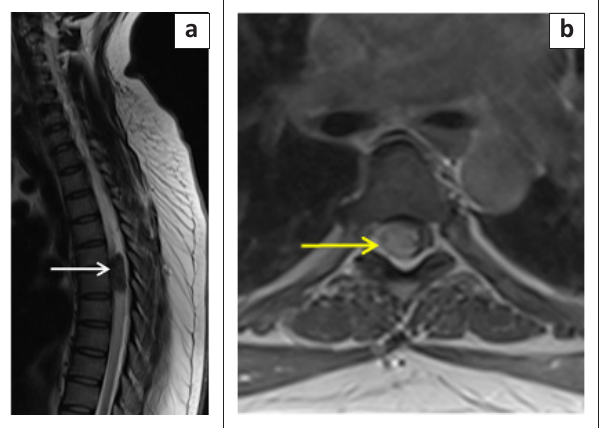
FIGURE 9: Intramedullary solitary fibrous tumour in a 38-year-old woman. Sagittal T2-weighted image (a) reveals the characteristic T2 hypointense mass (white arrow) in the thoracic cord. Contrast-enhanced axial T1-weighted image (b) demonstrates homogenous contrast enhancement (yellow arrow).